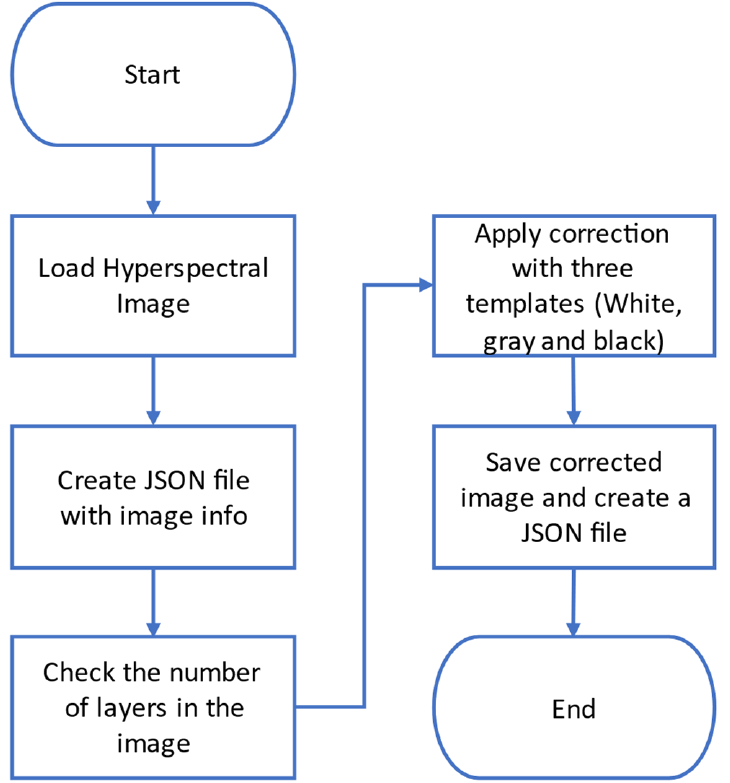
Figure 11. Flowchart followed in MATLAB for multispectral images correction.